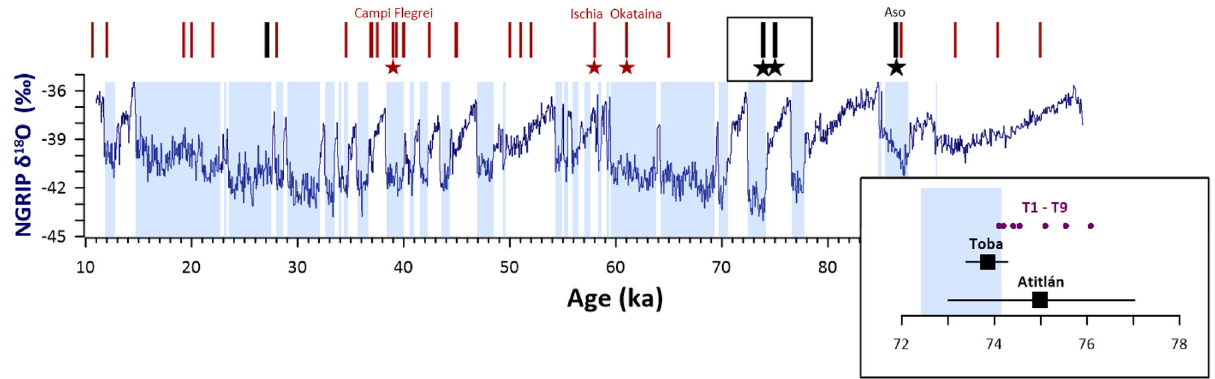
Fig. 1 Timing of known eruptions exceeding magnitude 7, relative to the Greenland δ 18 O record. 50-year averaged δ 18 O values from the North Greenland Ice Core Project (NGRIP) on the Greenland Ice Core Chronology 2005 (GICC05) model-based extension time scale, with stadials corresponding to cooler temperatures (more negative δ 18 O) as blue shaded periods 2 . Known very large eruptions are shown as red (7 < M < 8) and black (M > 8) bars, and stars represent radiometric eruption dates. Inset: A comparison of Toba and Atitlán eruption dates, with 1 σ errors shown (black bars) 1,9 relative to the timing of Greenland Stadial 20 and bipolar sulfate anomalies (T1-T9; purple points) measured in the NGRIP and EDML ice core 12